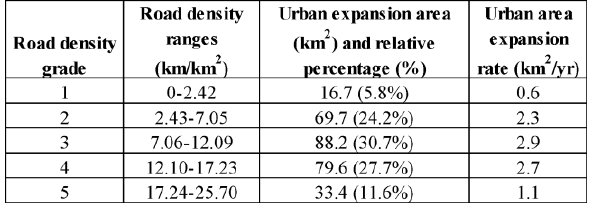
Figure 5. General structure of a SLEUTH model (Source: Al- shalabi et al.